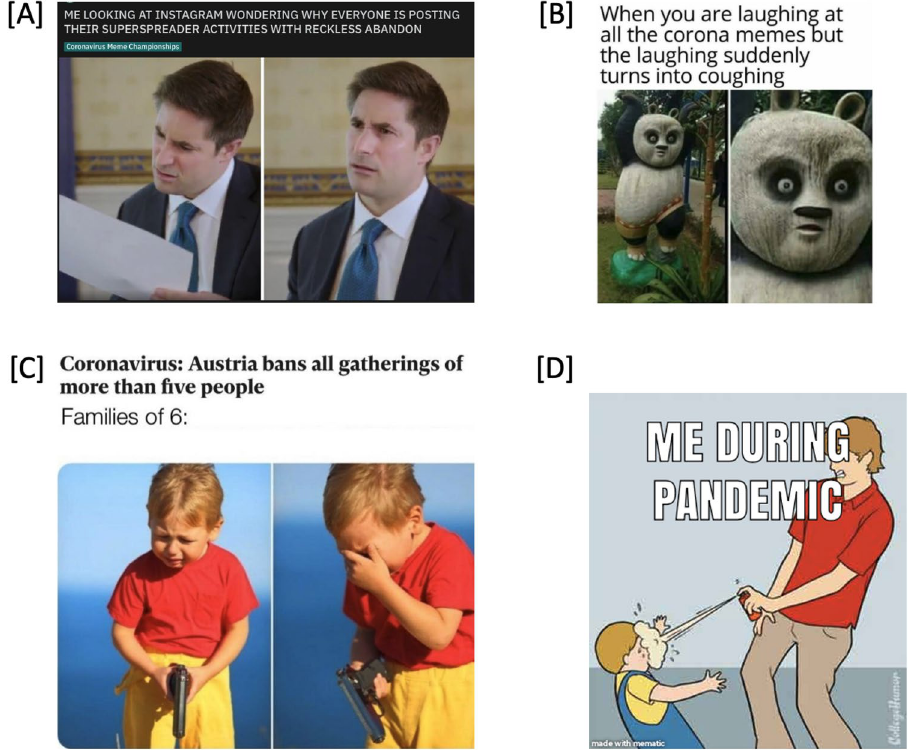
Figure 1. Four examples ( A – D ) of COVID-19 internet memes. All images used were gathered from the public domain each marked with either the Public Domain Mark 1.0 or CC0 1.0 Universal licence. No alterations were made. Title and Artist: Unknown. Image Source: